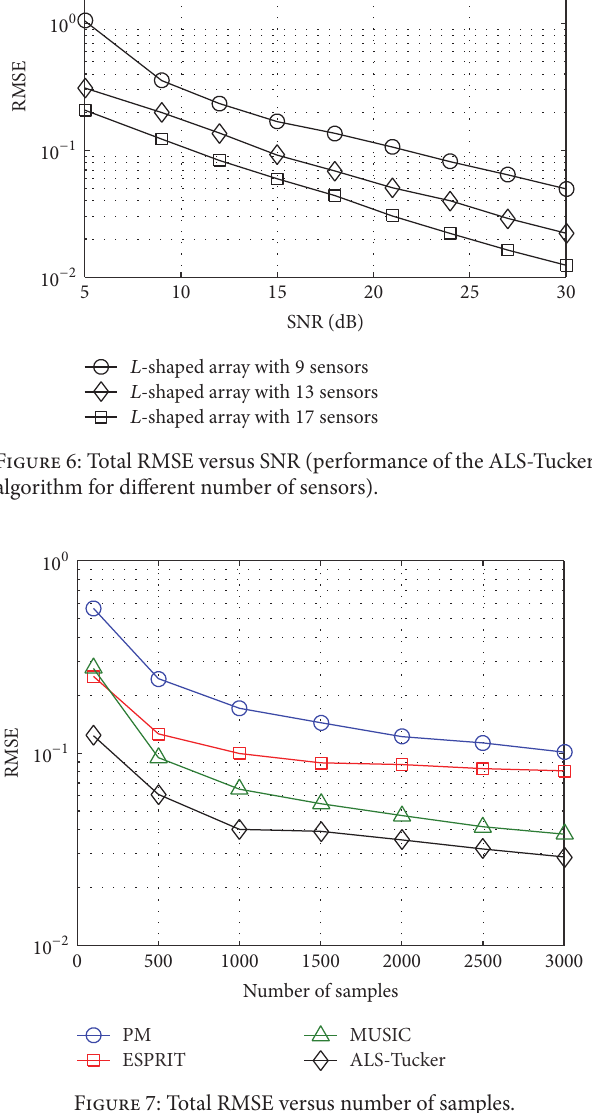
Figure 7: Total RMSE versus number of